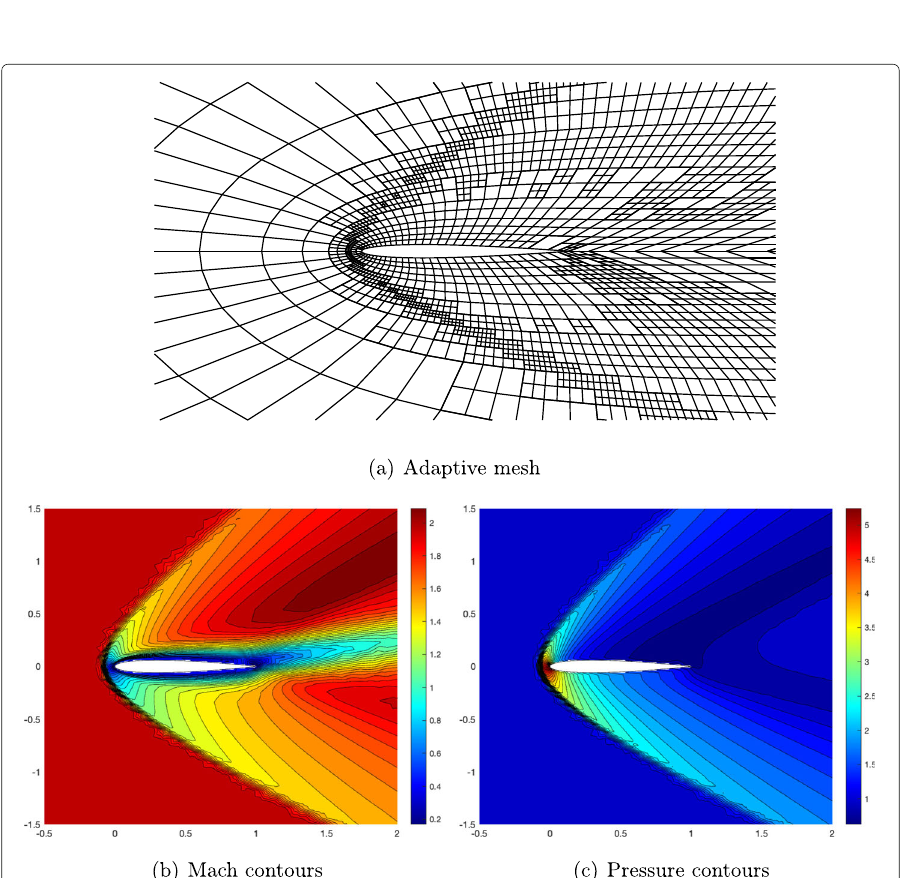
Fig. 12 ( a ) Adaptive mesh and the contour plots corresponding to P 2 solution for supersonic flow past a NACA0012 airfoil, 30 equally spaced contour lines are used to plot ( b ) Mach number from 0.15 to 2.15, and ( c ) pressure from 0.61 to